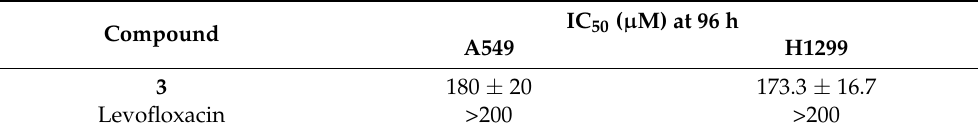
Figure 3. Cell survival percentages for A549 and H1299 cell lines after 96 h treatment with compound 3 and levofloxacin. Table 3. Cytotoxicity against A549 and H1299 cells following 96 h exposure.